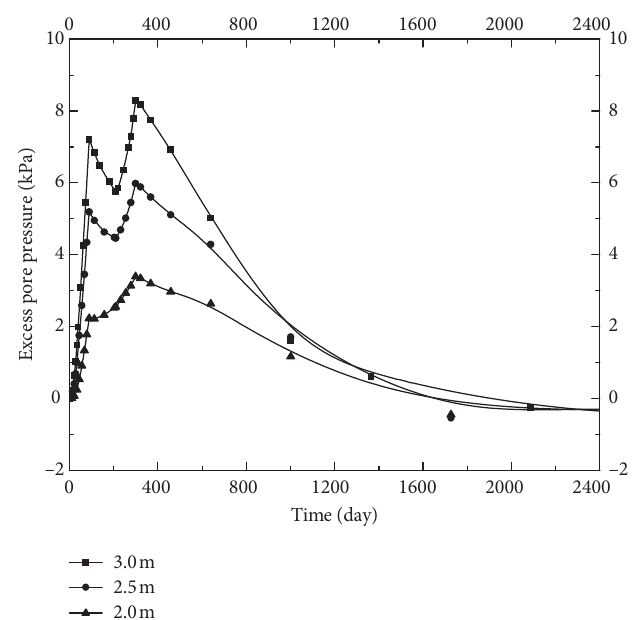
Figure 7: Excess pore pressure versus time with different pile